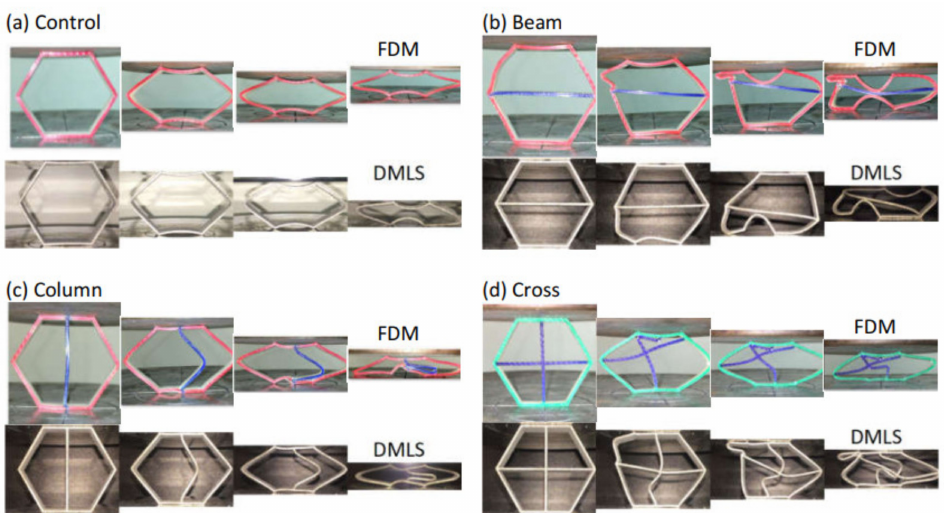
Figure 4. Crushing behavior of the two sets of honeycomb configurations under quasi-static axial compression. The first raw with the colored specimens are the polymer set while the bottom structures with the black background are the metallic set. ( a ) Control; ( b ) Beam; ( c ) Column; ( d )